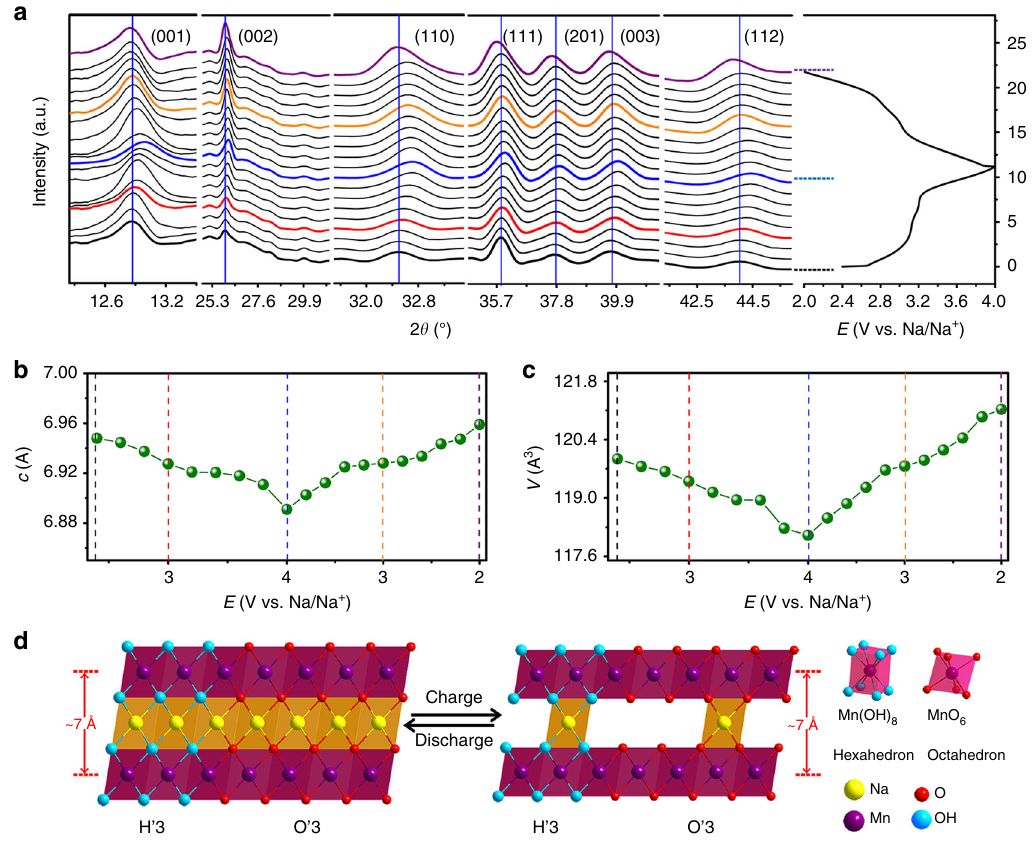
Fig. 5 Structure evolution upon Na intercalation/deintercalation. a In situ XRD patterns collected during the fi rst discharge/charge of the Na/S4 half cell under a current rate of C/10 at a voltage range between 2.0 and 4.0 V. b and c Evolution of the c -lattice parameter and volume during